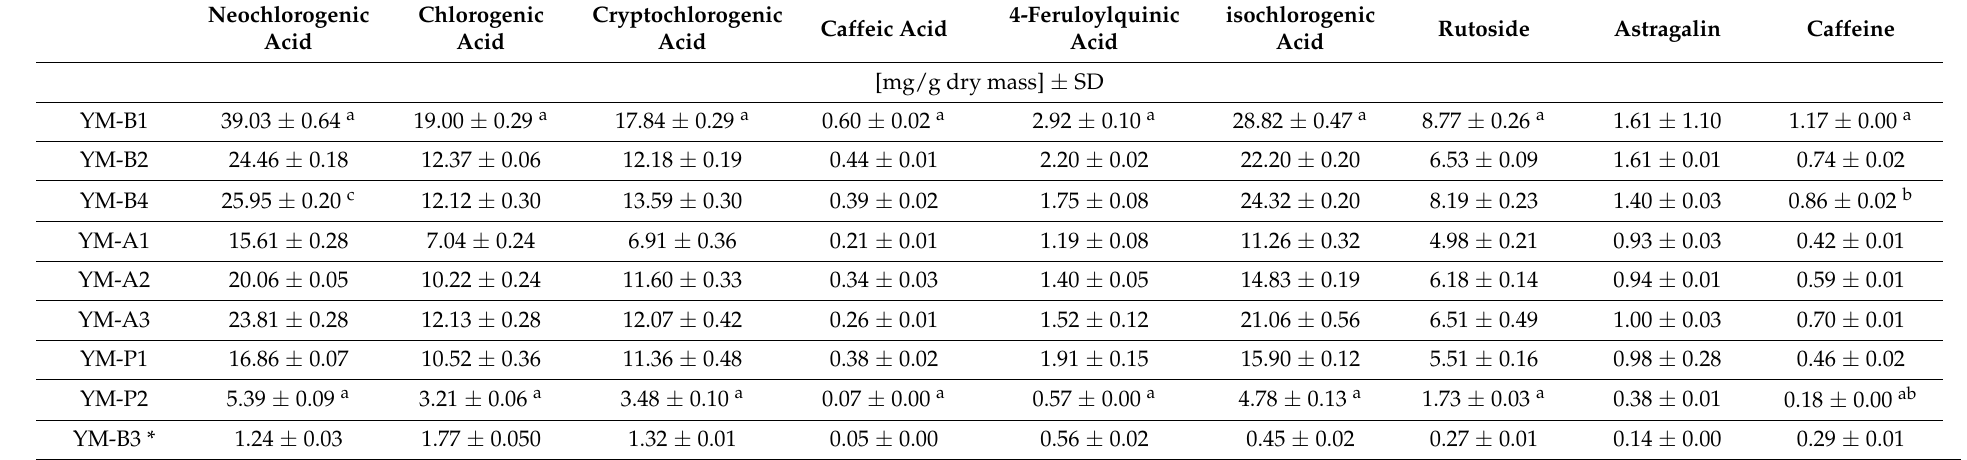
Table 3. Content of organic compounds in yerba mate samples analyzed in the present